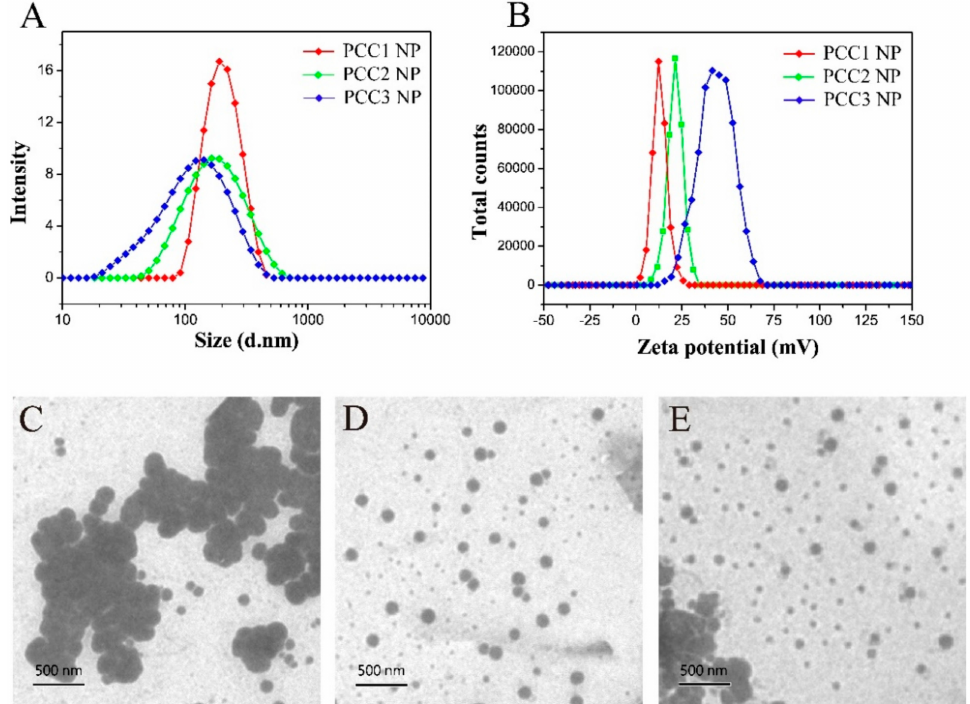
Figure 4. The size distributions ( A ); and zeta potential ( B ) of PCC1, PCC2 and PCC3 NPs. Transmission electron microscopy (TEM) images of: PCC1 NP ( C ); PCC2 NP ( D ); and PCC3 NP ( E